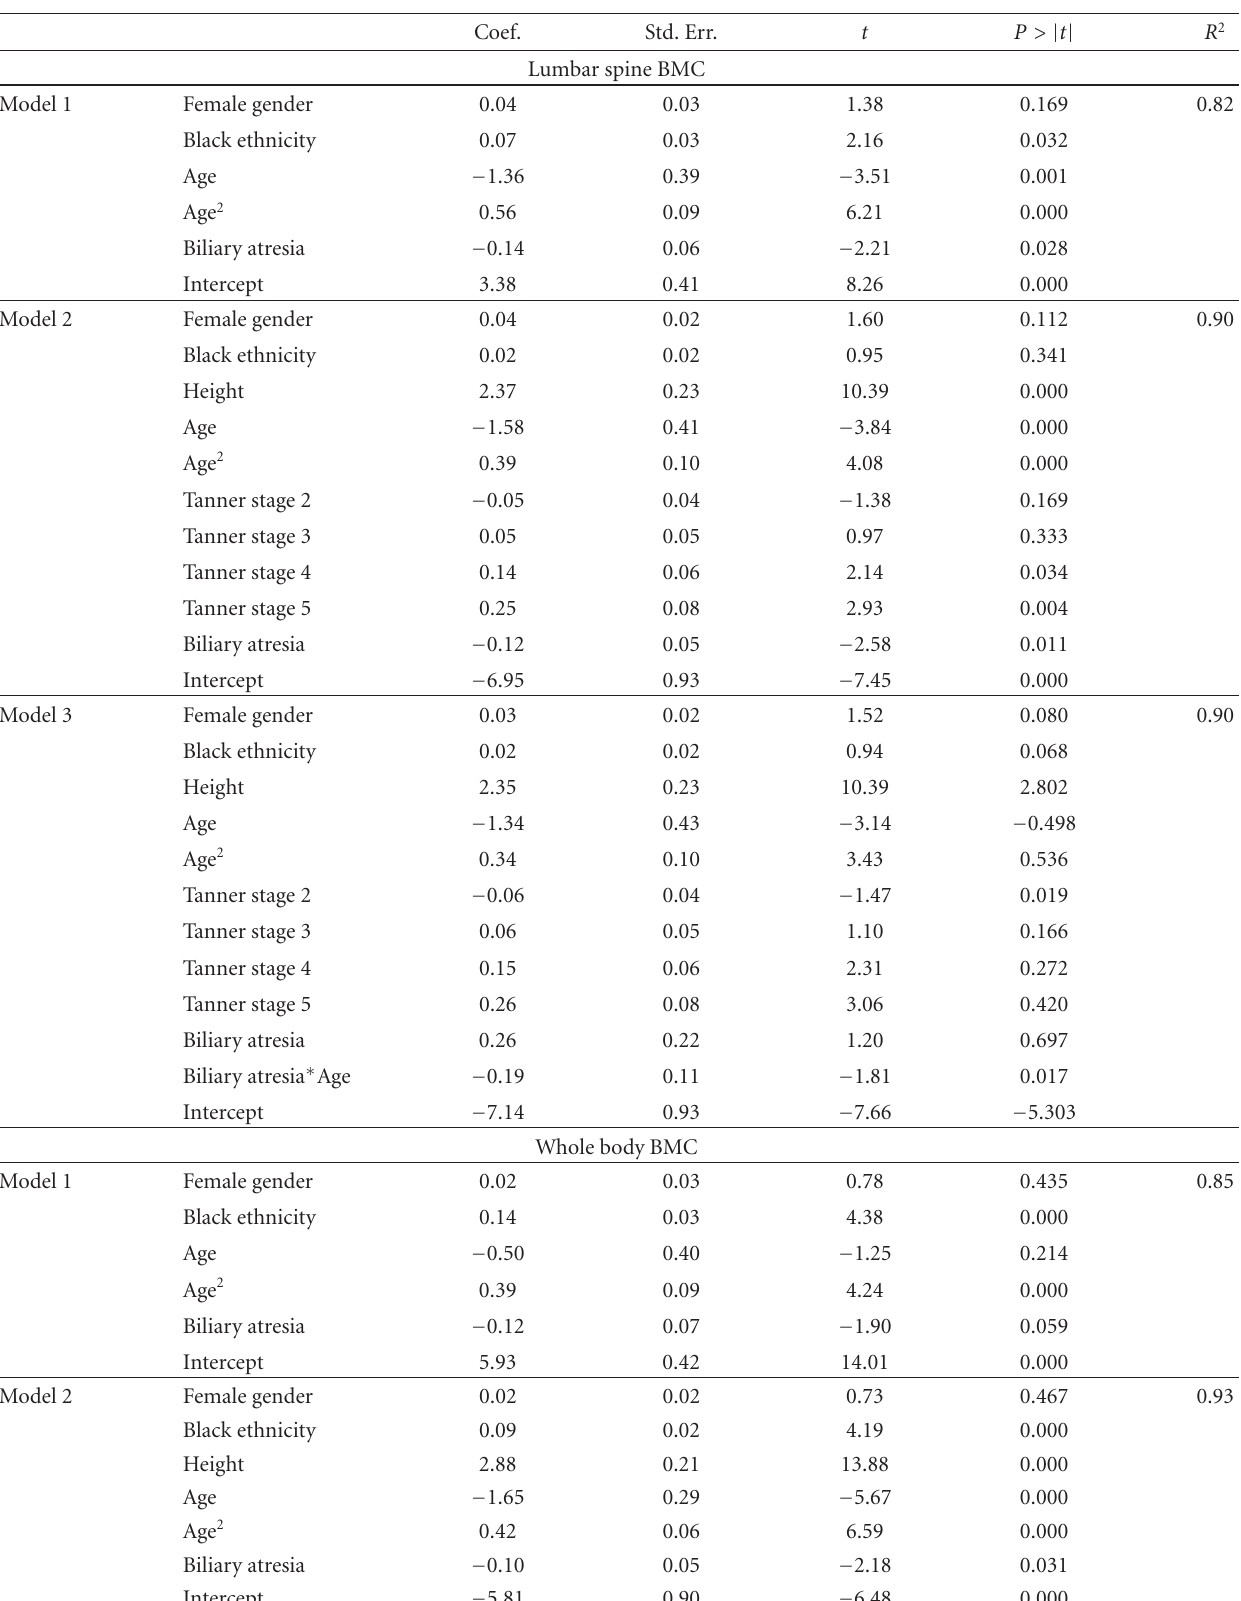
Table 2: Multivariable regression models of lumbar spine and whole body BMC in biliary atresia versus control groups adjusting for age, gender, race and height. Coef. Std.